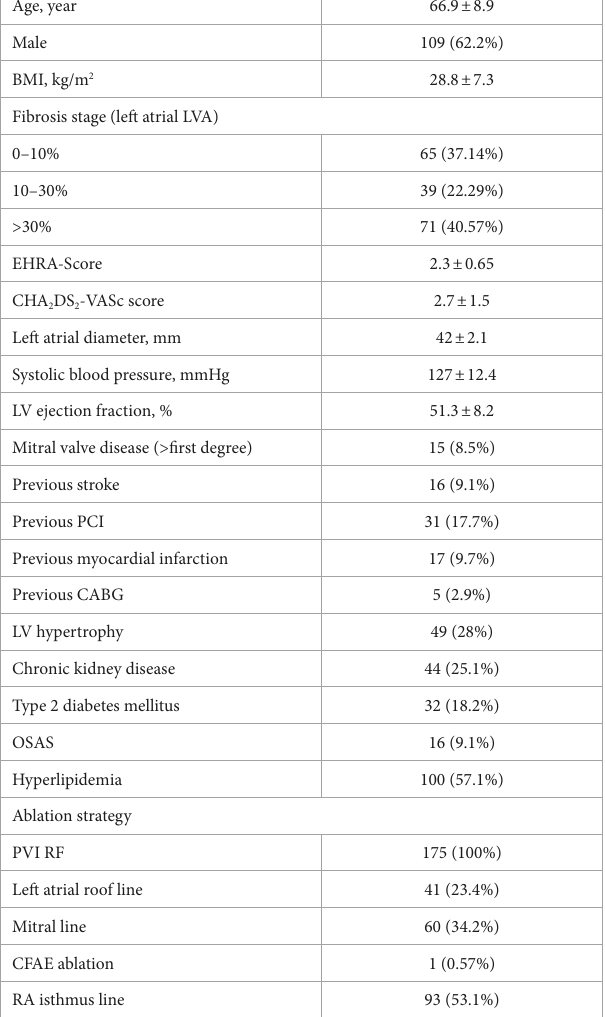
TABLE 1 Demographic and clinical characteristics of AF patients included in the